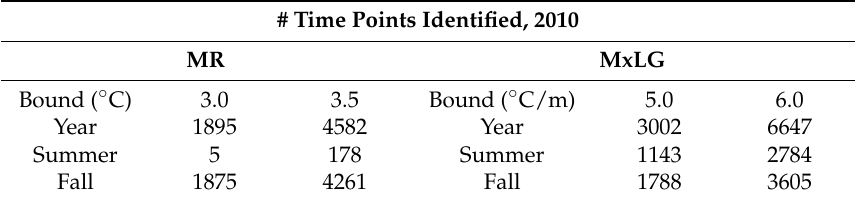
Table 5. Method comparison by number of points identified for different seasons, 2010. # Time Points Identified,